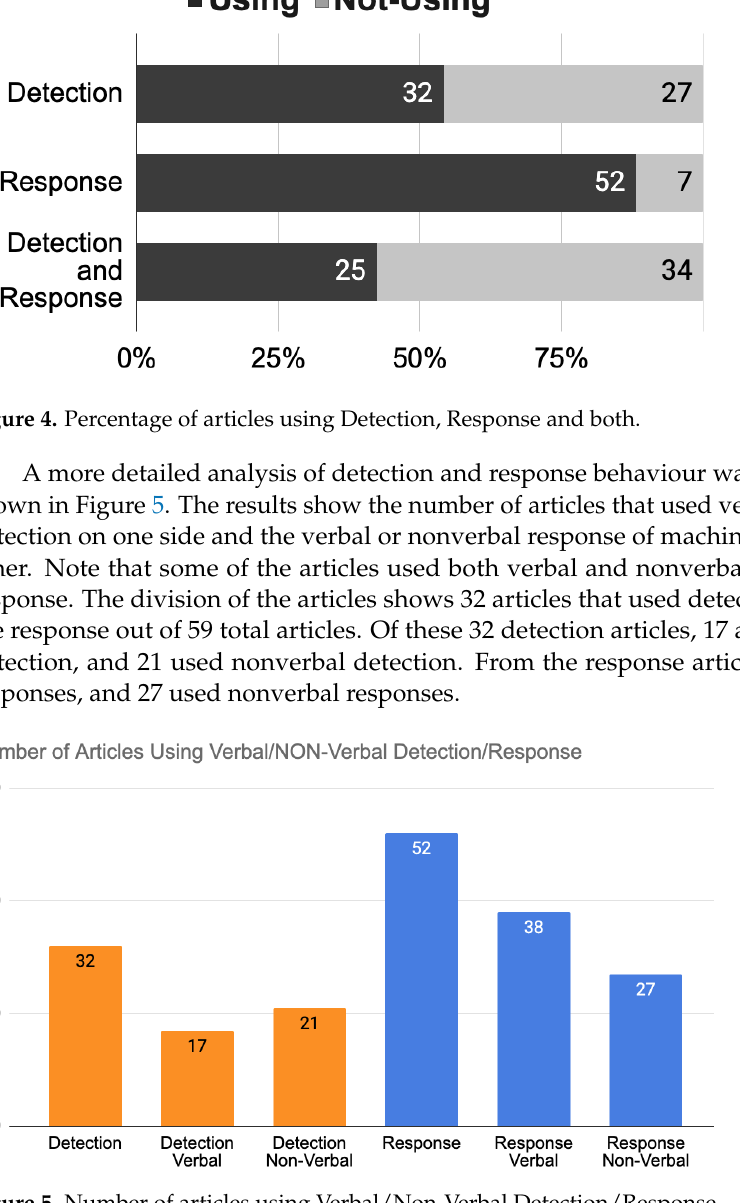
Figure 5. Number of articles using Verbal/Non-Verbal